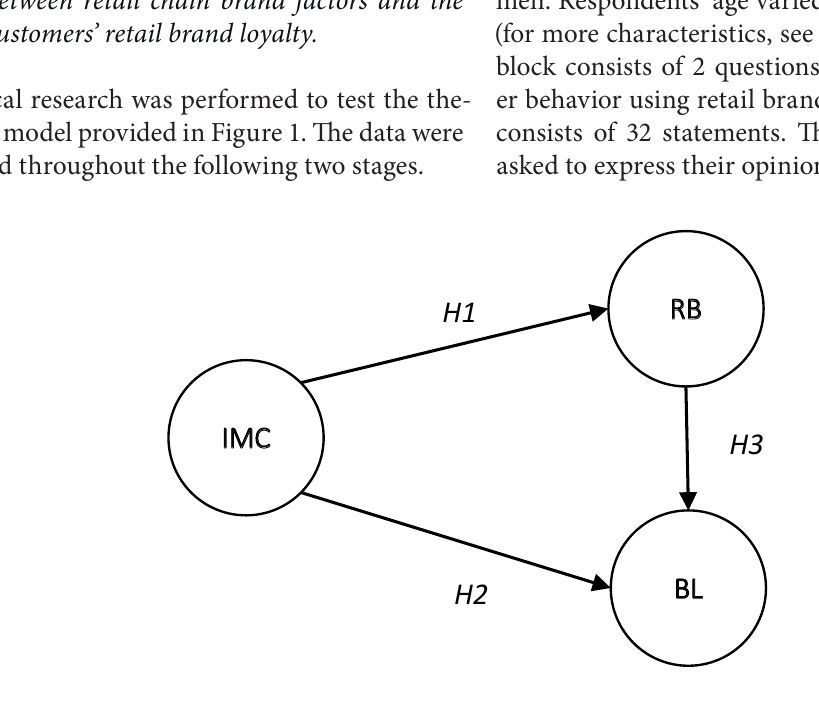
Figure 1. The theoretical framework of the